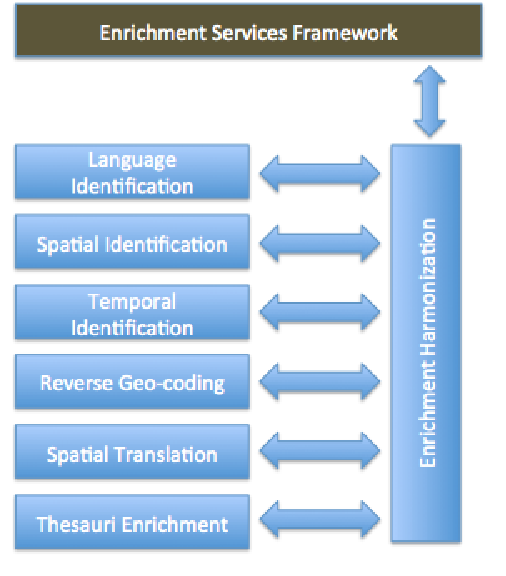
Figure 4. Enrichment services framework